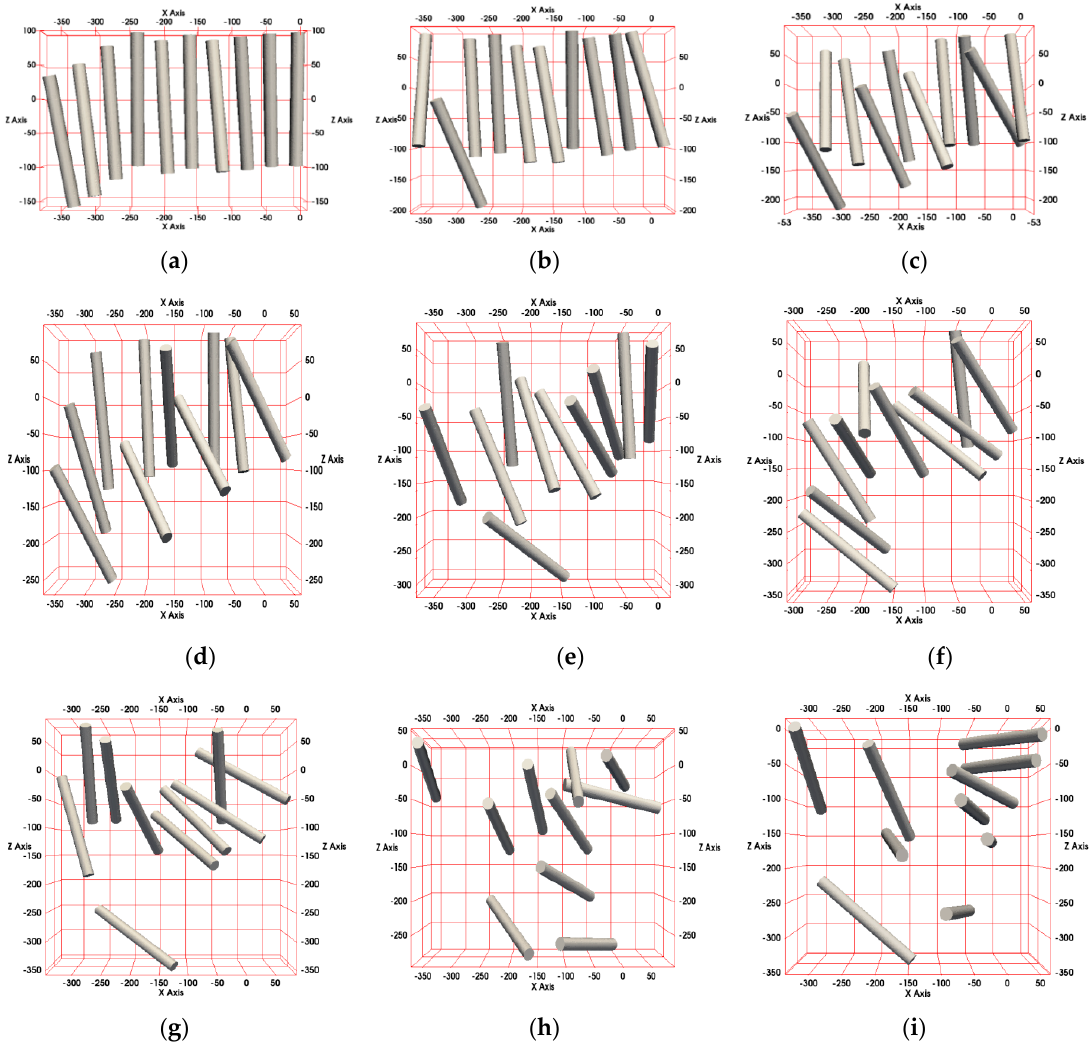
Figure 13. Fiber orientations used in the simulations for random angle ranges, depicted in steps of 10°: ( a ) 10°, ( b ) 20°, ( c ) 30°, ( d ) 40°, ( e ) 50°, ( f ) 60°, ( g ) 70°, ( h ) 80°, and ( i ) 90°.